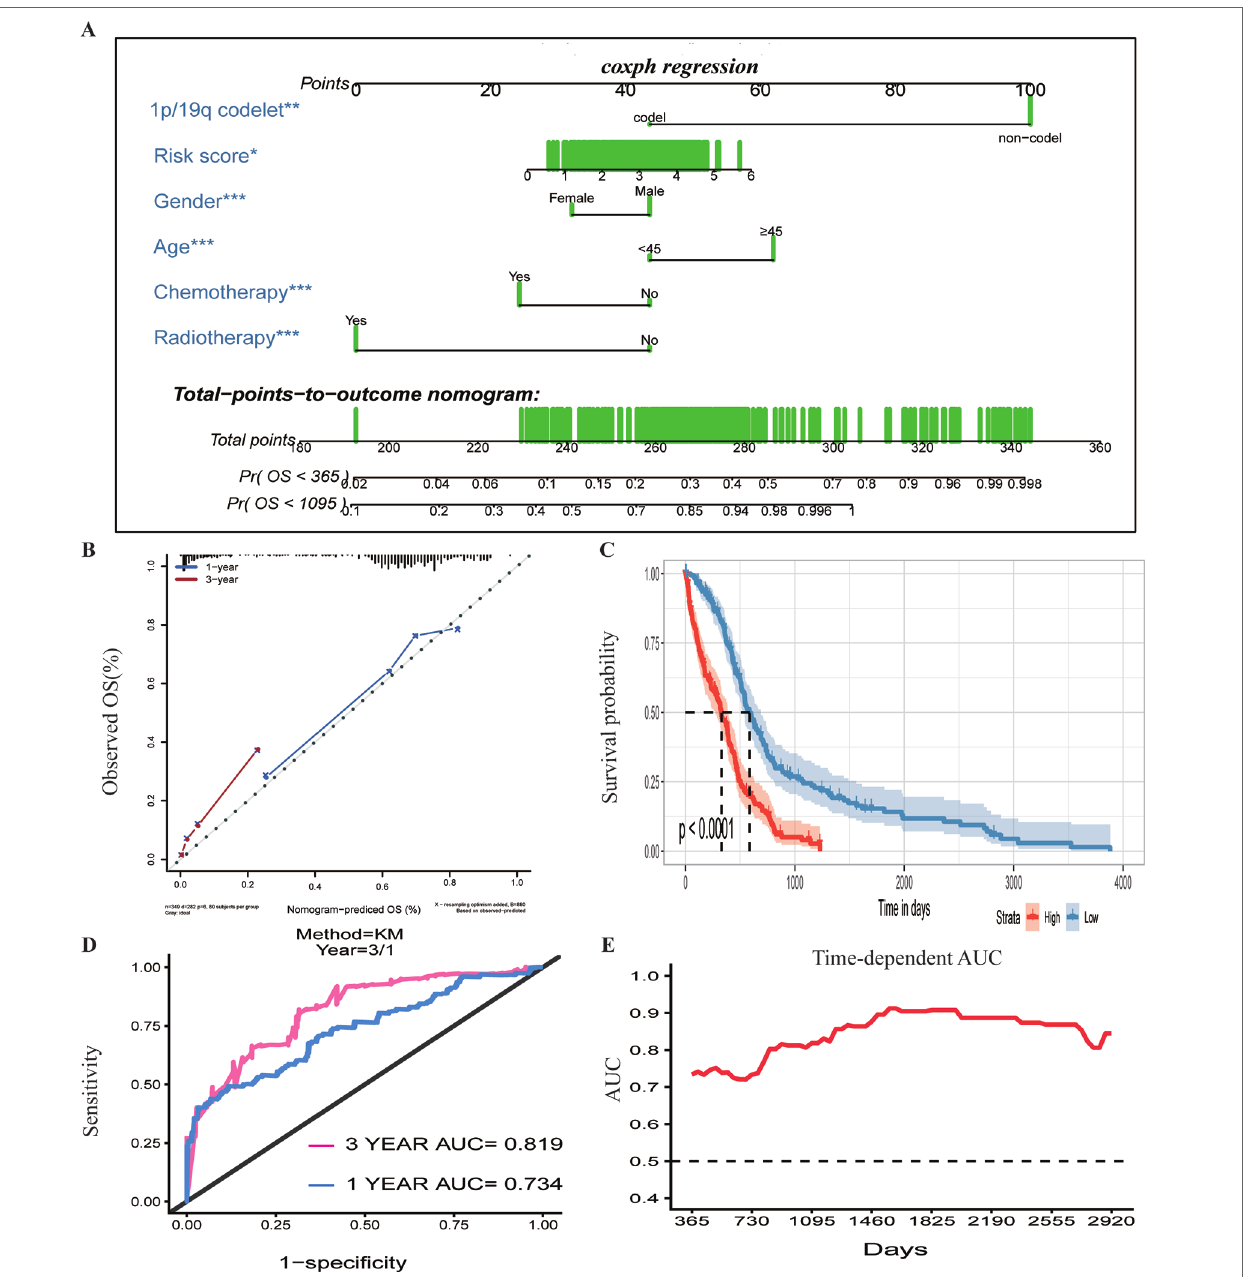
FiGURe 4 | Prognostic value of the integrated classifier is independent of clinical feature. (A) Prognostic nomogram for glioblastoma (GBM) patients with six chief characteristics. (B) The calibration curve of overall survival (OS) at 1/3 year. Nomogram-predicted probability of the OS is plotted on the x -axis, and the observed OS is plotted on the y -axis. (c) Comparison of OS between high-risk-score group and low-risk-score group. * P < 0.05, ** P < 0.01, *** P < 0.001. (D, e) The time- dependent receiver operating characteristic (ROC) for predicting the 1/3-year survival and area under the curve (AUC) for the risk assessment model in The Cancer Genome Atlas (TCGA)